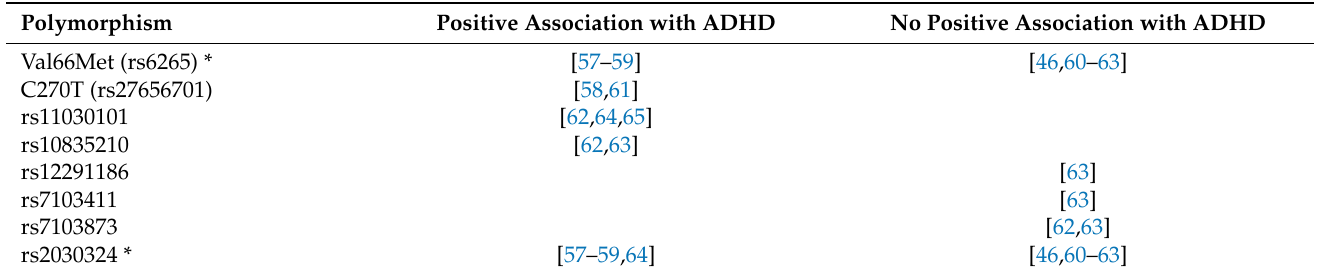
Table 1. Polymorphisms of the BDNF gene studied in relation with ADHD incidence. * Polymorphisms for which contradictory results have been reported. rs, reference SNP ID